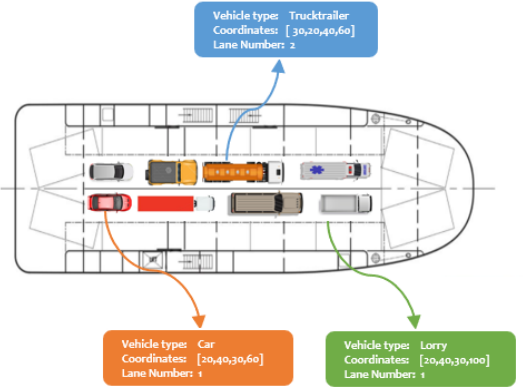
Figure 2. A contrived deck plan showing the vehicle loading operation. Each vehicle type occupies different regions and the respective lane